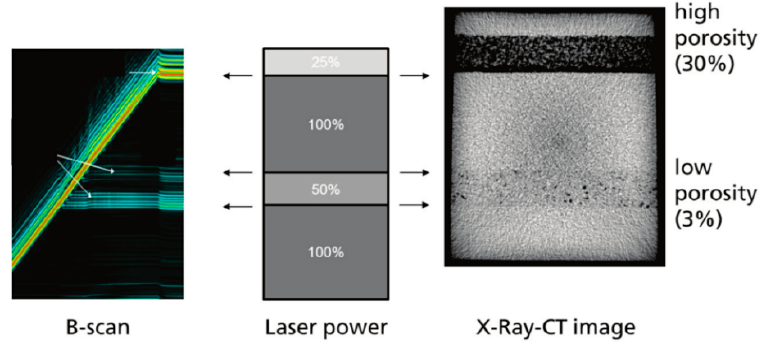
Figure 17. Ultrasound scan and corresponding X–ray CT scan [67].